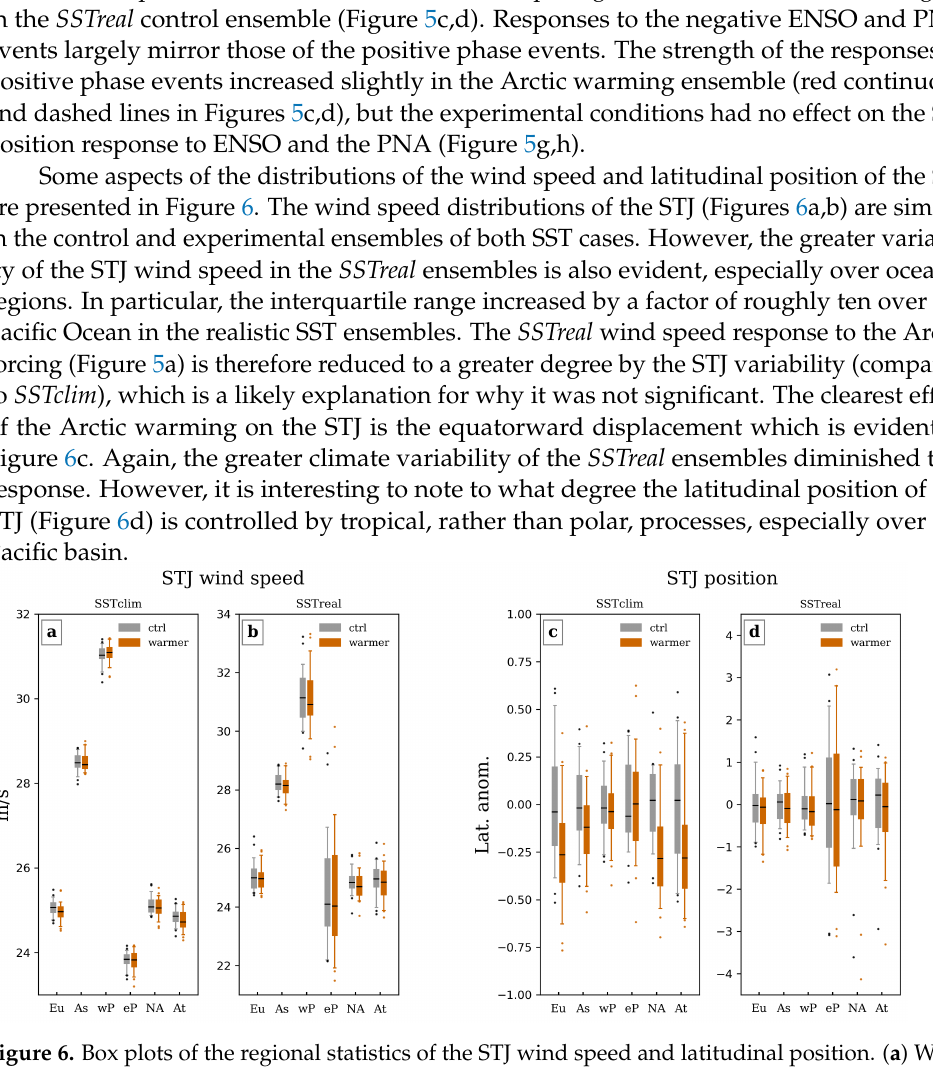
Figure 6. Box plots of the regional statistics of the STJ wind speed and latitudinal position. ( a ) Wind speed for SSTclim . ( b ) Wind speed for SSTreal . ( c ) Latitudinal position for SSTclim . ( d ) Latitudinal position for SSTreal . The central mark indicates the median and the bottom and top edges of the box indicate the 25th and 75th percentiles. The outliers are plotted individually using the “dot” symbol. Gray shading is used for the control ensembles and orange for the low-sea ice Arctic Warming ensembles. Note different scales of y